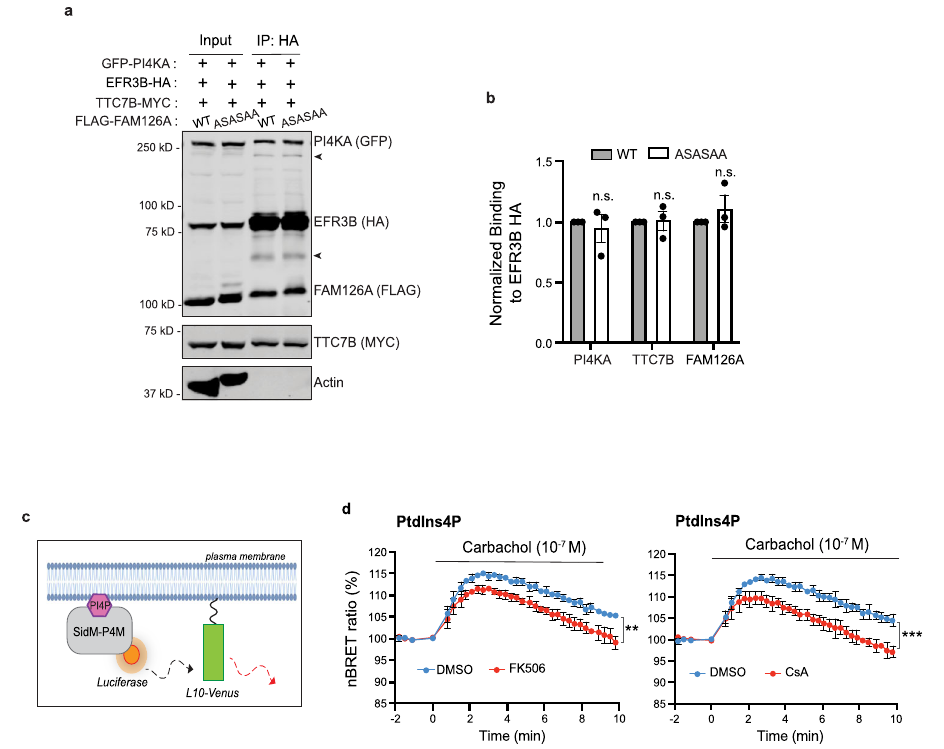
Fig. 6 CN regulates PI4P synthesis by the PI4KA complex. a Representative immunoblot showing analysis of the PI4KA complex components in anti-HA immunoprecipitates of HeLa cells expressing GFP-PI4KA, EFR3B-HA/TTC7B-MYC with WT or ASASAA mutant FLAG-FAM126A ( n = 3 independent experiments). Arrow points to the uncut P2A form. Arrowhead denotes non-speci fi c antibody bands. b Co-puri fi cation of each component with EFR3B-HA (from a ) is quanti fi ed as respective signals/EFR3B-HA signal in bound fractions normalized to respective signals/Actin signal in input fractions. Data are the mean ± SEM ( n = 3 independent experiments). n.s. not signi fi cant using multiple, unpaired, two-tailed t -tests. c Cartoon representation of the BRET pair used in experiments shown in d . PI4P binding domain of the Legionella SidM protein (SidM-P4M, gray) attached to Renilla Luciferase (orange) as the donor and Venus (green), targeted to the PM using the fi rst 10 amino acids of Lck, L10, as the acceptor. d Normalized BRET ratios re fl ecting changes in PM PI4P levels in response of carbachol stimulation (10 − 7 M) in HEK293T cells transiently expressing muscarinic receptor, M 3 R, pre-treated with DMSO (blue), or CN inhibitors (red): FK506 (1 µ M) (left) and Cyclosporin A, CsA (10 µ M) (right) for 1 hr. Data shown are mean ± SD ( n = 4 independent experiments). (cid:3)(cid:3) p = 0.0063, (cid:3)(cid:3)(cid:3) p = 0.0004 using Kolmogorov – Smirnov